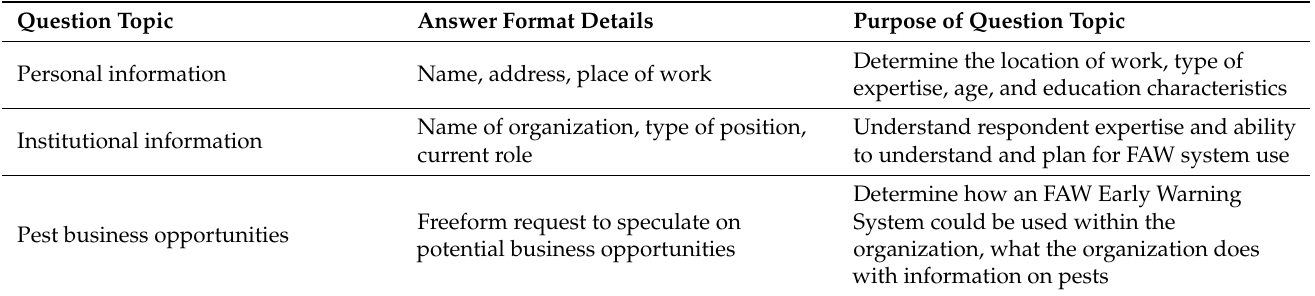
Figure 1. Location of respondents in East Africa, with 25 located in Nairobi, Kenya. Table 1. Characteristics of questions in a survey on information on prediction tool for FAW outbreak in East Africa. Complete questionnaire is available in the Supplementary